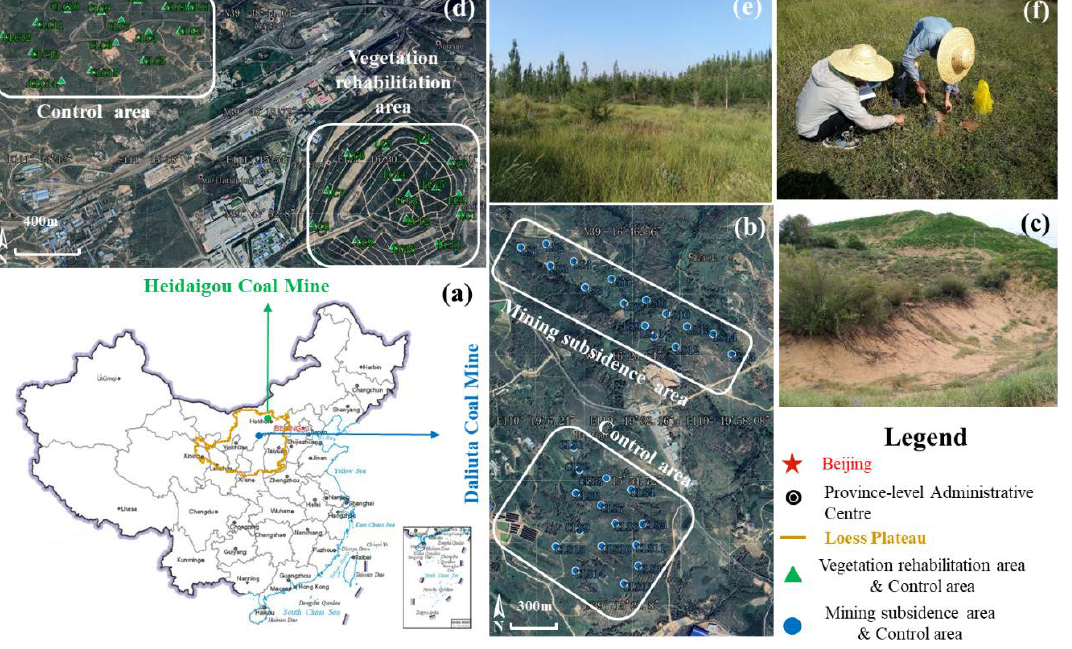
Figure 1. The study area and sampling sites of coal mining substance and vegetation rehabilitation. ( a ) Location of Daliuta and Heidaigou Coal Mines; ( b ) Sampling points of mining subsidence and control area in Daliuta Coal Mine; ( c ) Photograph of mining subsidence in Daliuta Coal Mine; ( d ) Sampling points of vegetation rehabilitation and control area in Heidaigou Coal Mine; ( e ) Photograph of vegetation rehabilitation in Heidaigou Coal Mine; ( f ) Photograph of soil sampling.